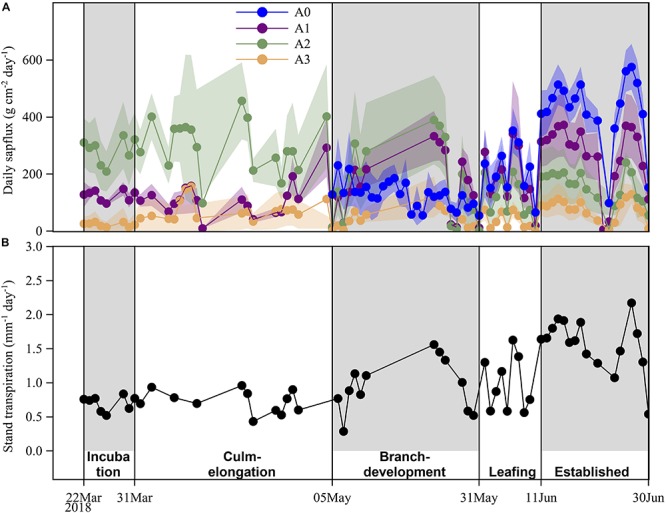
(A) Age-specific daily accumulated sap flux of the four age categories (A0, A1, A2, A3) and (B) stand transpiration of the studied Moso bamboo stand over five phenological stages (incubation, culm-elongation, branch-development, leafing, established stages of newly sprouted culm). The presented age-specific sap flux densities are averaged values from 3 to 6 bamboo culms for each age category, and the standard deviation of daily age-specific sap flux densities is presented with the corresponding color band for each age. Daily stand transpiration was obtained from one plot, so no variation is presented here due to lack of replicates.